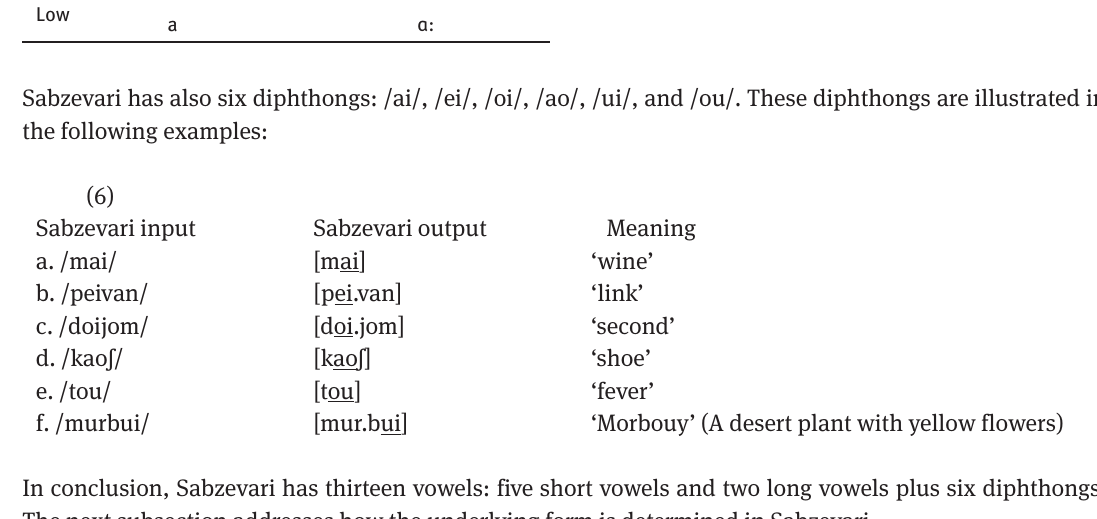
Front Mid Back High i u,u: Mid-High e o Mid-Low Low a